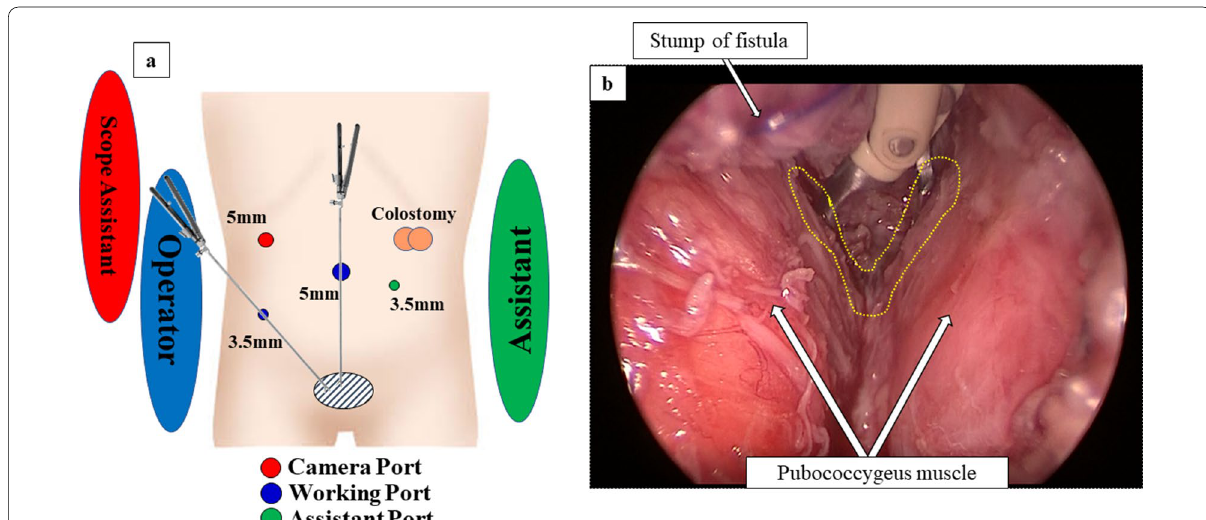
Fig. 3 a Trocar layout for LAARP. b Laparoscopic view of deep pelvic space. After transection of RBUF, muscle complex including pubo-rectal sling (dot line) and pubococcygeus muscle (arrows) were clearly